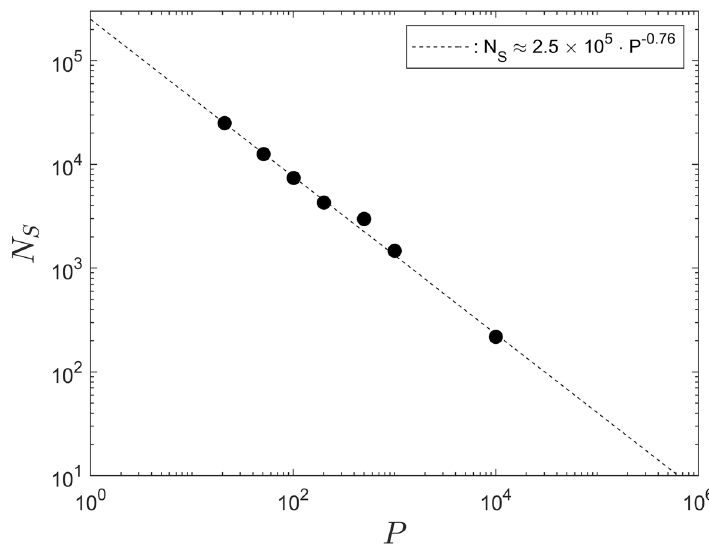
Figure 8. The saturation step, N S as a function of the population size P